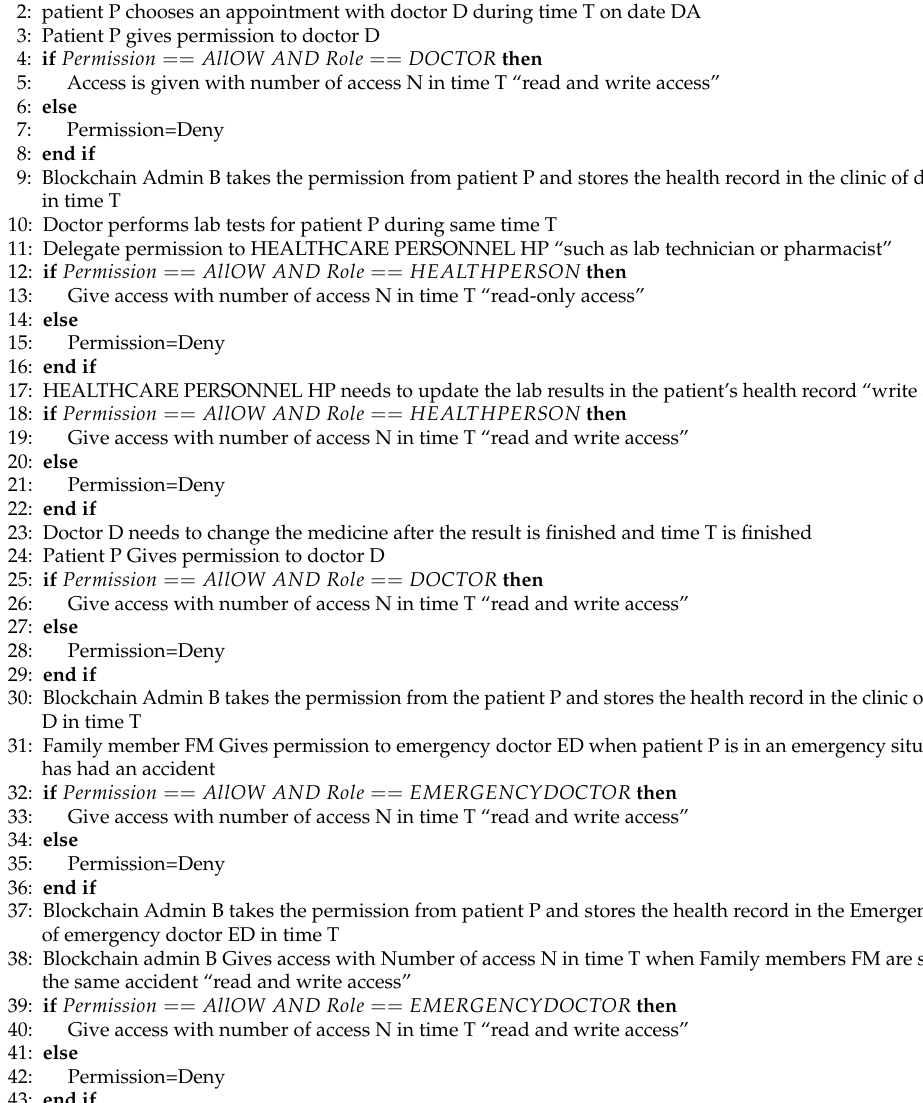
Algorithm 1 Patient-centric health record access control in a